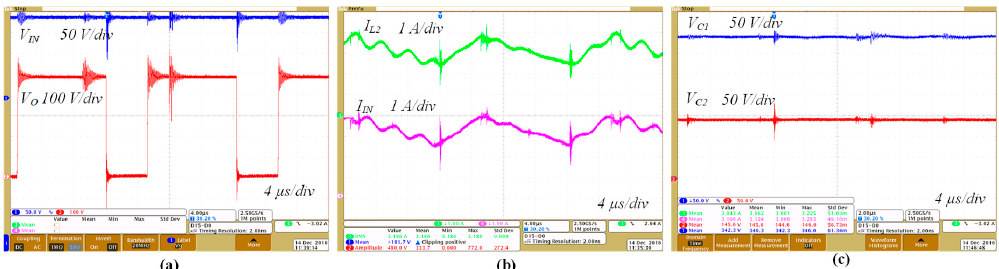
Figure 19. Experimental results of the qZS inverter: ( a ) Input voltage ( V in ) along with the dc-link voltage ( V o ), ( b ) input current ( I in ) along with the inductor current ( I L 2 ), and ( c ) voltage across capacitors V C 1 and V C 2